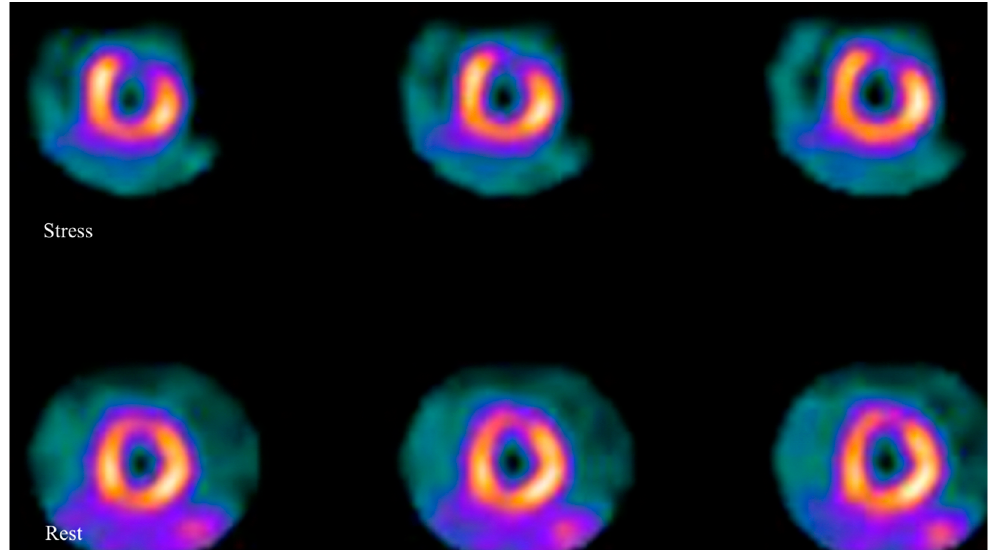
Figure 2. Axial images of a myocardial scintigraphy performed in a pediatric patient with KD: images show a severe reversible perfusion defect in the anterior wall of left ventricle, which is suggestive for myocardial ischemia.